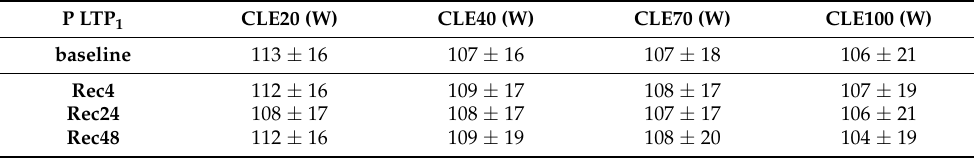
Figure 2. Heart rate (HR), lactate (La), and glucose (Glu) values at rest, LTP 1 , and peak from submaximal incremental ergometer exercise test (IE) performed at 4, 24, and 48 h (Rec4, Rec24, and Rec 48) after constant-load cycle ergometer exercise tests with maximum duration (CLE100) and 70, 40, and 20% (CLE70, CLE40, and CLE20) of CLE100 at the same intensity, shown as a percentage of the baseline IE values determined immediately before each CLE. Table 2. Power output (P) at the first lactate turn point (LTP 1 ) from the submaximal incremental cycle ergometer exercise test at baseline and 4, 24, and 48 h of recovery (Rec 4, Rec 24, and Rec 48) after each constant-load exercise test